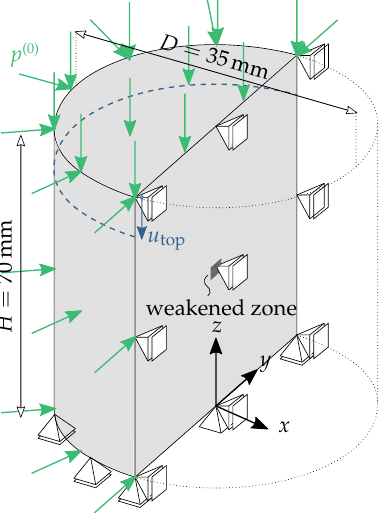
Figure 7. Geometry and boundary conditions of the specimen for the triaxial compression